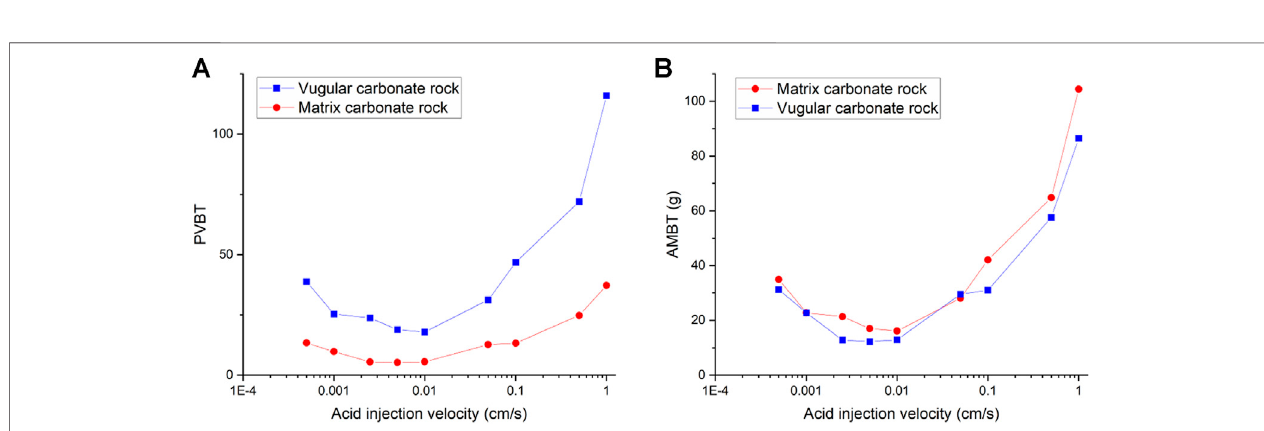
FIGURE 3 | Effect of the acid injection rate on acidizing curves of the vugular carbonate rock: (A) PVBT and (B) AMBT.